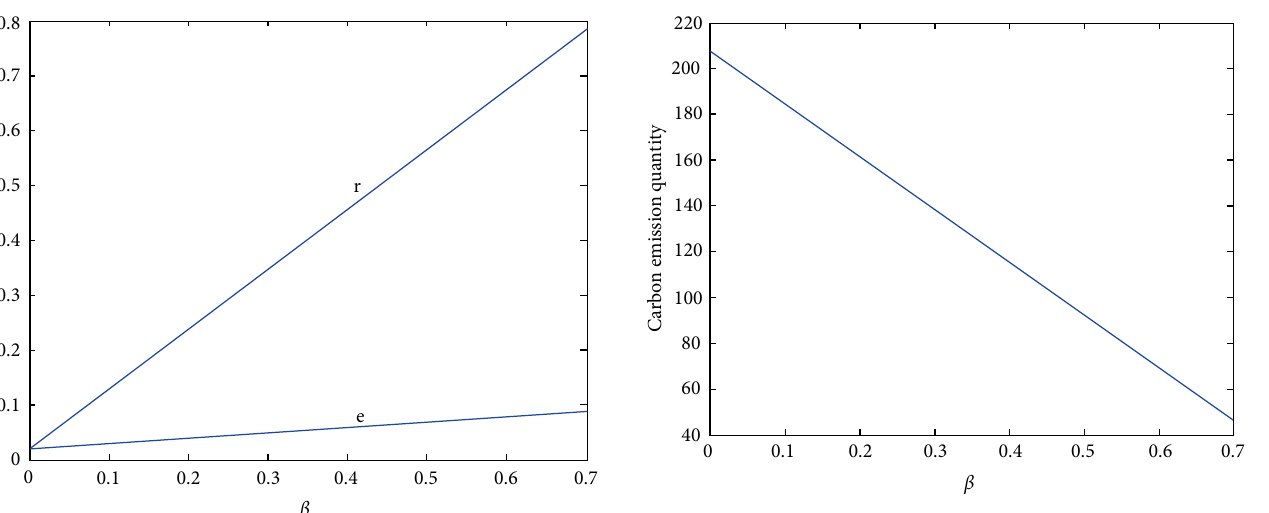
Figure 4: Figure of carbon capture rate and effort varying with 𝛽 .